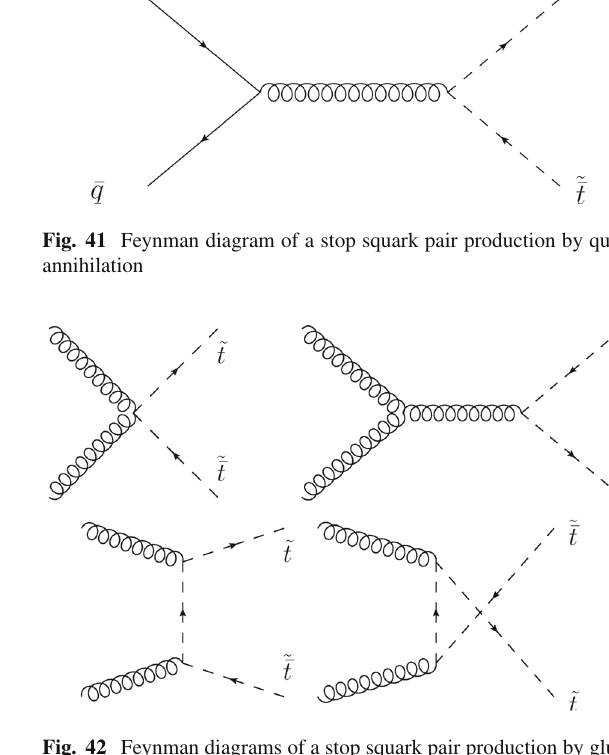
Fig. 42 Feynman diagrams of a stop squark pair production by gluon fusion